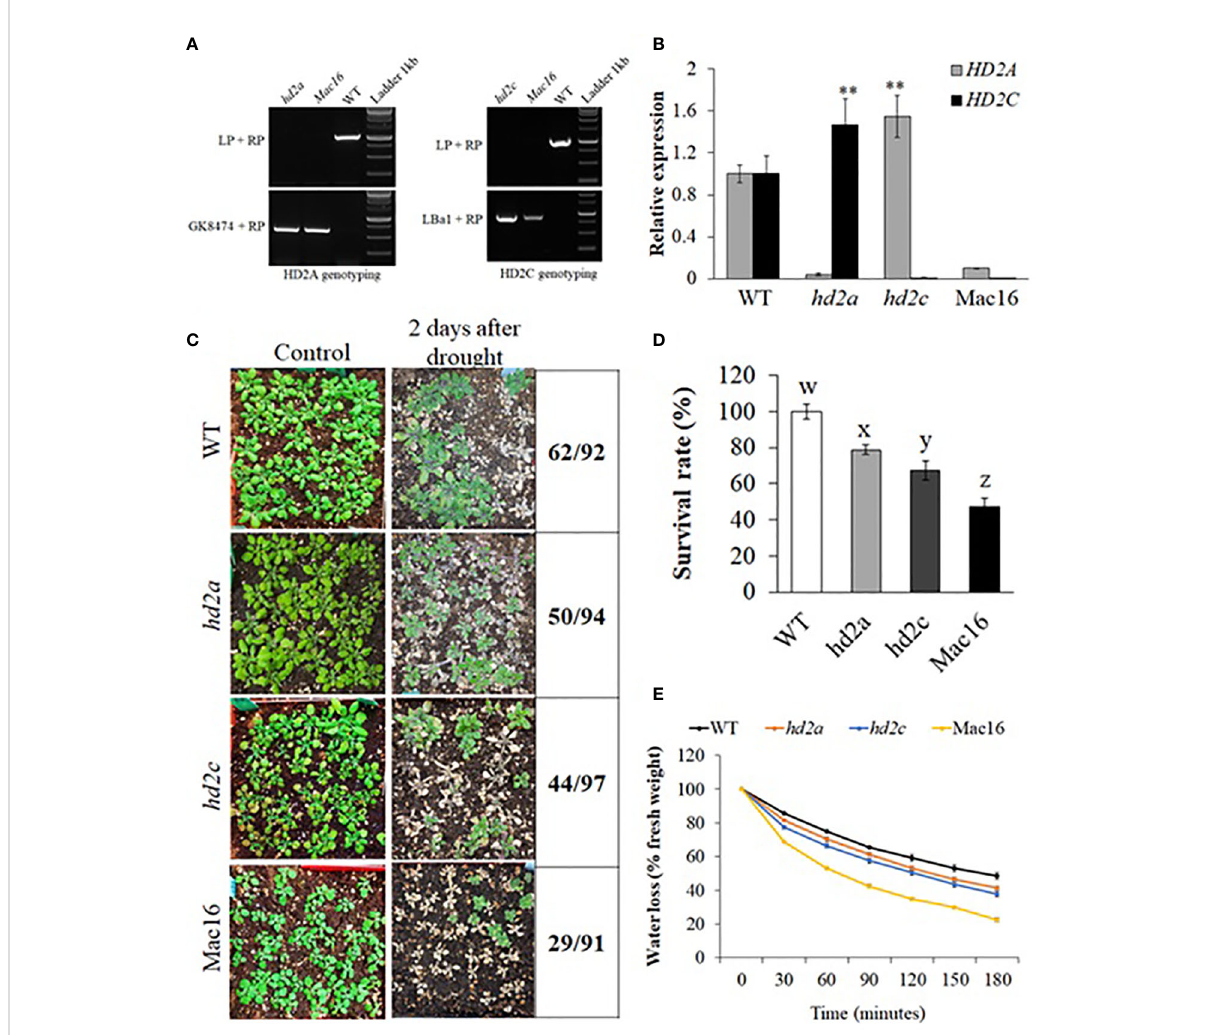
FIGURE 2 Con fi rmation of hd2 mutants and drought stress-induced changes in the hd2 mutant lines. (A) Genotyping of double mutant line Mac16 for HD2A and HD2C genes. Gene-speci fi c left (LP) and right (RP) primers along with TDNA primers GK8474 and LBa1 were used in genotyping. (B) Relative expression of HD2A and HD2C in WT, the single mutants hd2a and hd2c , and the double mutant Mac16. Data shown are means ± standard errors (n = 3). (**p < 0.01). (C) Images of WT, hd2a , hd2c , and Mac16 plants under control and two days after rewatering, following 11 days of drought stress. (D) Survival rates of hd2a , hd2c , and Mac16 relative to WT plants after drought stress. Data shown are means ± standard errors (n = 3) from three independent experiments. In each experiment, at least 30 plants of each genotype were used to calculate the survival. The signi fi cance of the differences between different genotypes was determined by one-way ANOVA followed by post-hoc Tukey ’ s HSD tests. Lowercase letters indicate signi fi cant differences (p < 0.01). (E) Fresh leaf water loss measured in WT, hd2a , hd2c , and Mac16 at every 30-minute interval for the period of 180 minutes. Data shown are means ± standard errors (n = 3) from three independent experiments. In each experiment, measurements were taken from three plants (three leaves per